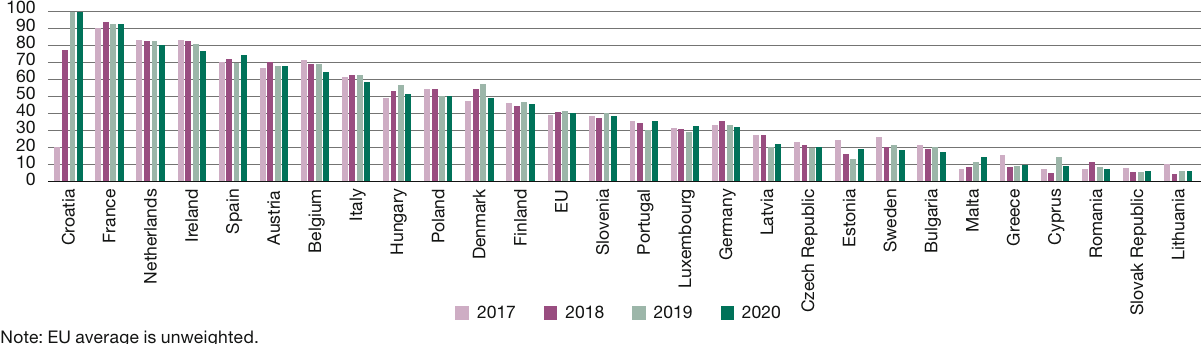
Proportion of procedures awarded using the most economically advantageous tender principle, 2017-2020